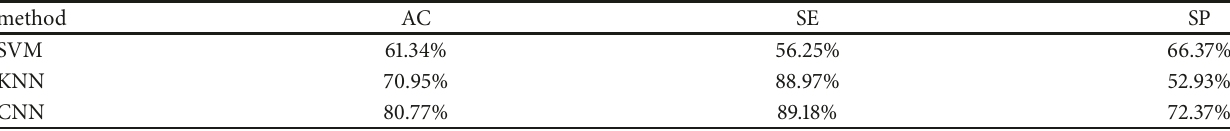
Table 3: Comparison of CNN with typical classification methods.